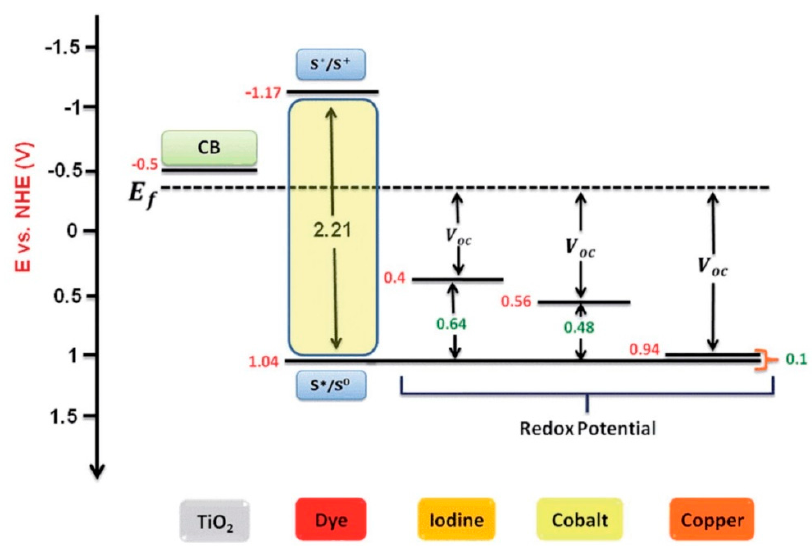
Figure 7. Illustration of energy level of photoanode and different redox mediators: I − /I 3 − , [Co(bpy) 3 ] 2+/3+ and [Cu(dmp) 2 ] 1+/2+ . Republished with permission of Royal Society of Chemistry, from ref. [20], Copyright (2018).